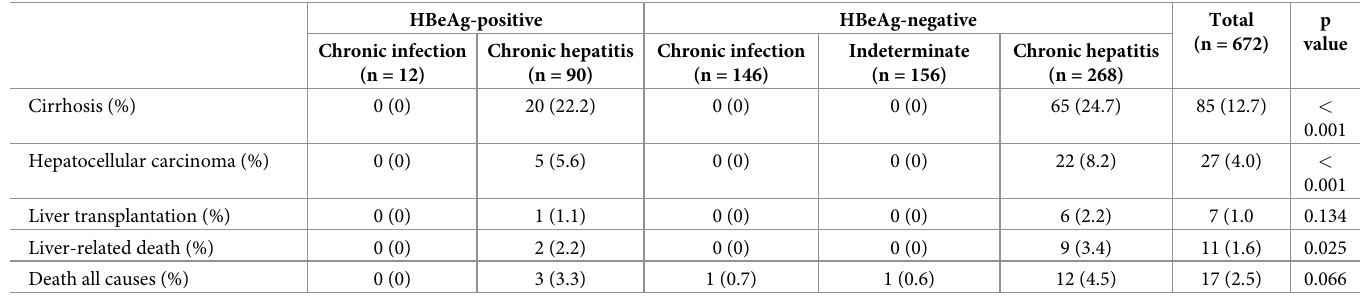
Baseline characteristics of HDV-coinfected patients Characteristics of HDV-coinfected patients are summarized in Table 2. The HDV-positive group was defined by positive anti-HDV serology independently of the presence or absence of detectable HDV RNA. Out of 672 patients, 648 (96.4%) had a test for anti-HDV. Of these, 46 (7.1%) presented a positive serology. Forty anti-HDV-positive patients (87.0%) had a test for HDV RNA by PCR. Of these, 28 had detectable HDV RNA (4.3% of the entire cohort, 70.0% of the tested anti- HDV-positive patients, 60.9% of all anti-HDV-positive patients). male and 50.0% of African origin. Age, sex and region of origin were similar among HDV-pos- itive vs . HDV-negative patients.